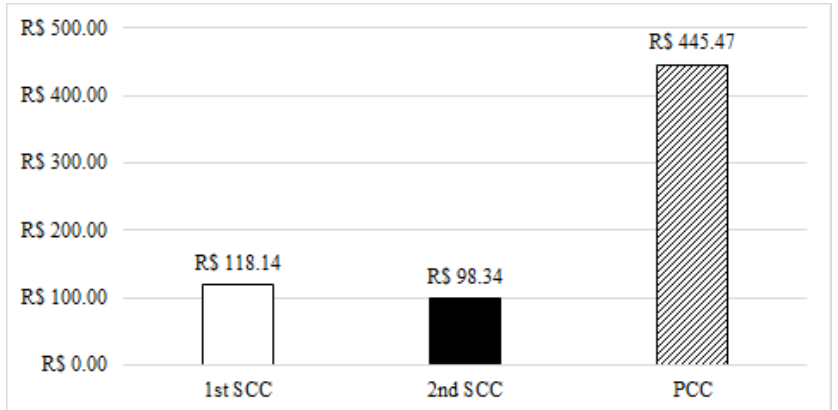
Graph 6. Comparison between labor cost for each pouring